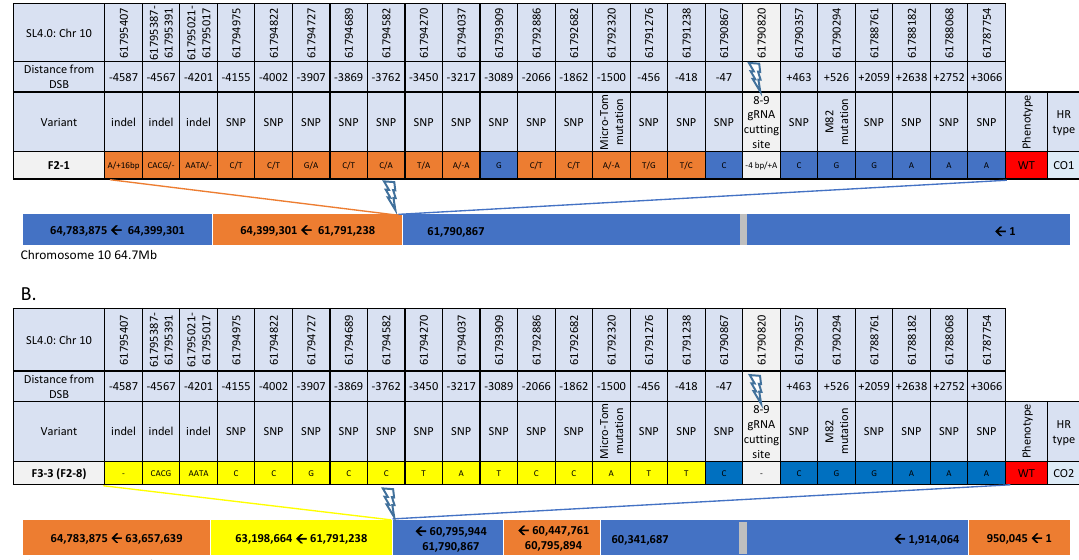
Figure 7. Whole genome sequencing of the two CO events from Plant#2 DSB-induced in CRTISO 8–9. Each plant was sent for whole genome sequencing. ( A ) F 2 -1: F 2 plant 1 and ( B ) F 3 -3 (F 2 -8) F 3 plant 3, progeny of F 2 plant 8 homozygote in the CRTISO region. Transition from one parental type, M82 (yellow) and Micro-Tom (blue), to a heterozygote state (orange), or to the other parental type correspond to IHSR events. Indels at the DSB site represent NHEJ events in one or both alleles. DSB site footprint was determined to be homozygote (single character), heterozygote (two characters divided by “/”), “-” in case no footprint is found. Lightning bolts represent the CRISPR/Cas9 DSB region. Grey boxes represents a rough estimate of the centromere region (SL4.0 Chr10: 22482995) based on